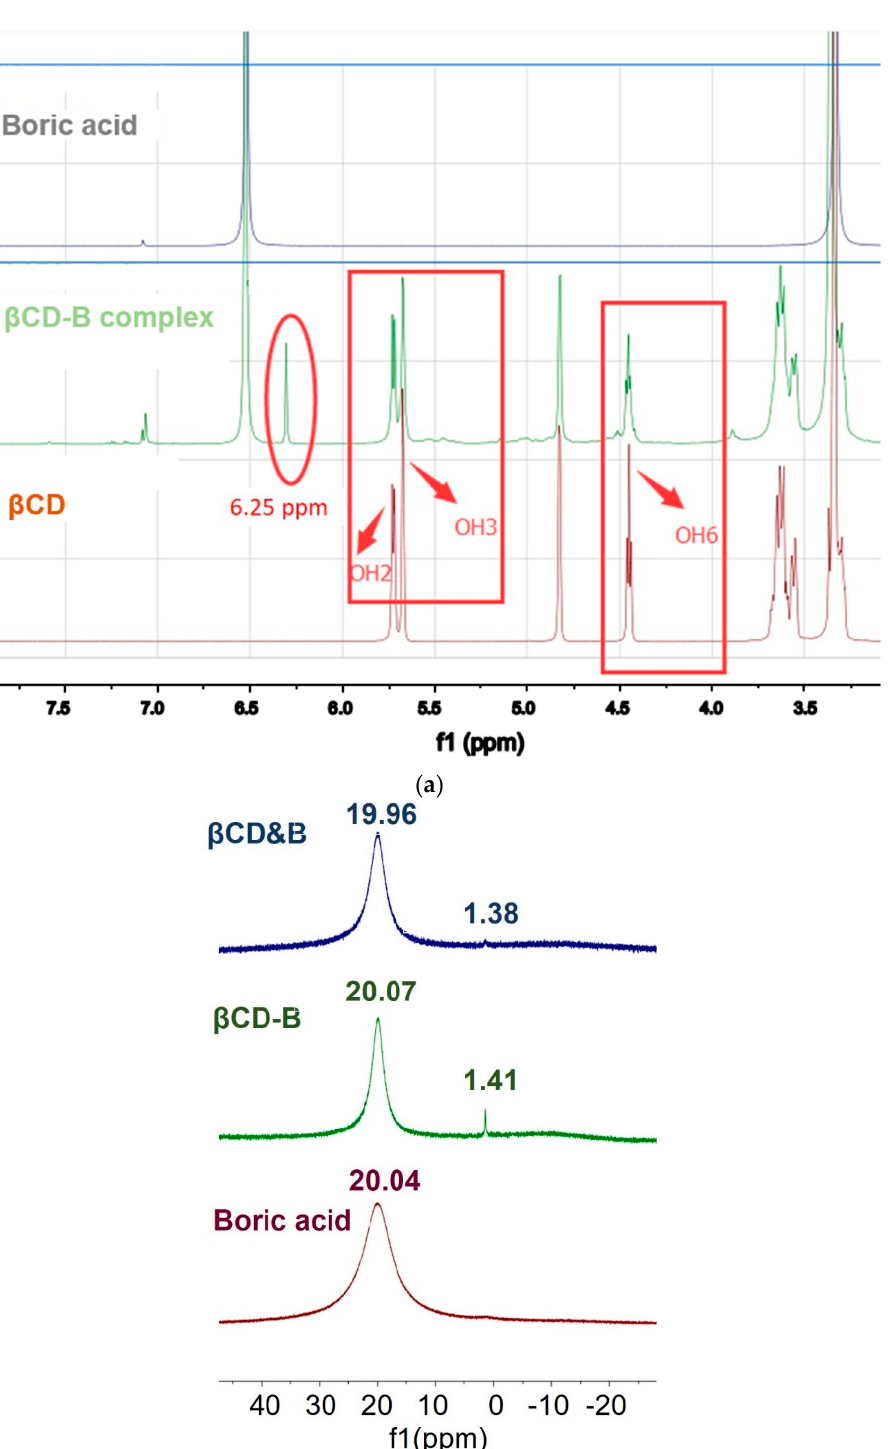
Figure 4. ( a ) 1 H Nuclear magnetic resonance (NMR) of boric acid, β CD–B complex and β CD in DMSO-D6 (TMS as internal references) and ( b ) B-11 NMR of boric acid, β CD-B complex and β CD&B physical mixture in DMSO-D6 (normalized).